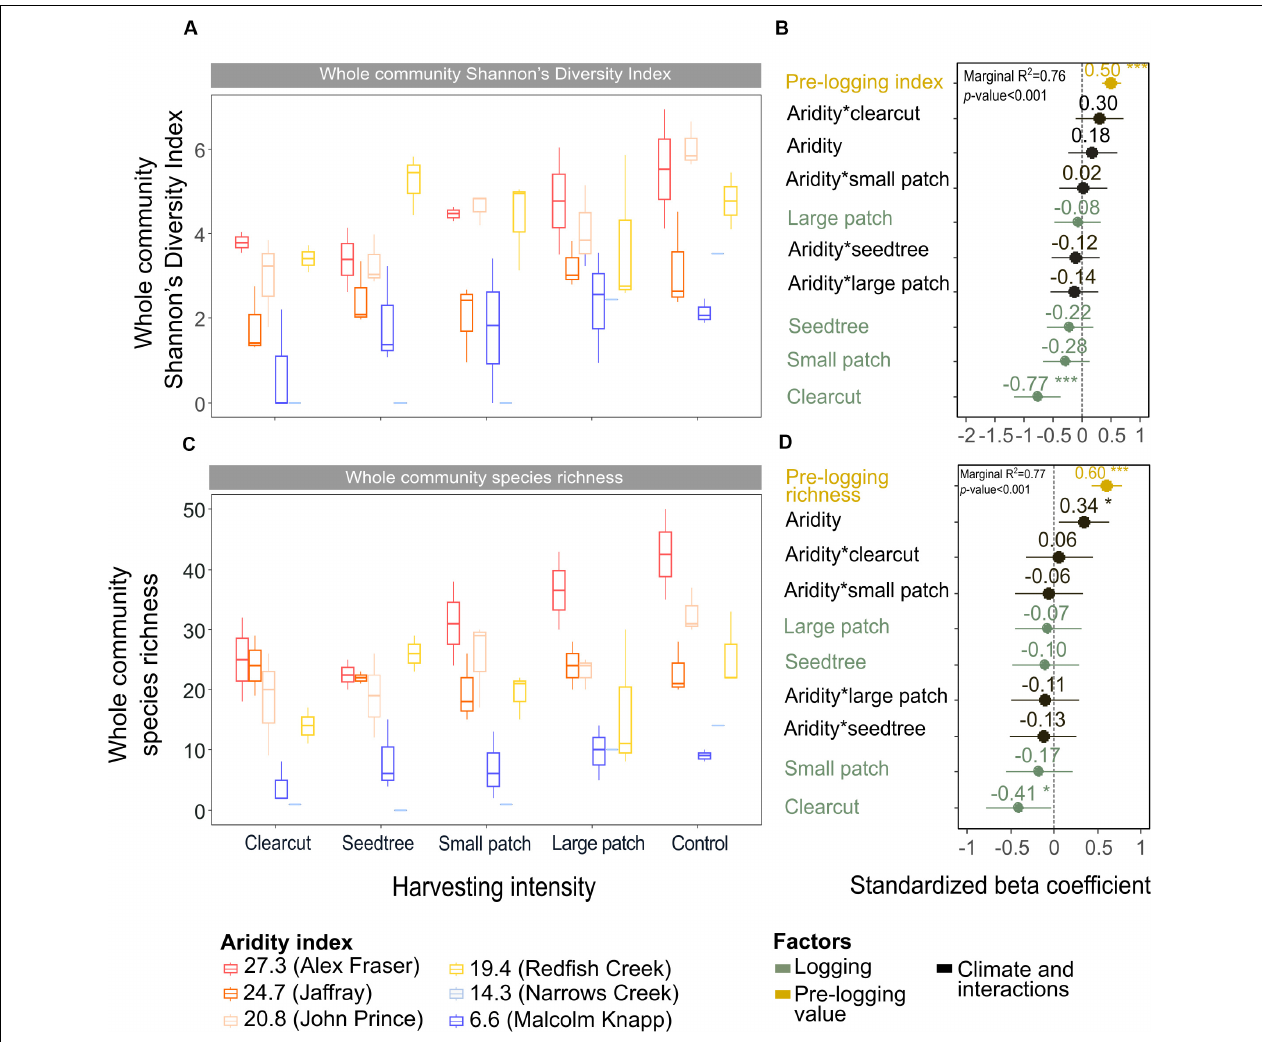
FIGURE 6 | Effect of harvesting intensity and climatic aridity on whole community Shannon’s diversity index (A,B) and plant species richness (C,D) of mixed Douglas-fir forests ( n = 3 for all locations, except Narrows Creek where n = 1, and Alex Fraser where n = 2). The counts for plant species richness include all vascular plants and bryoid species. (B,D) present standardized beta coefficients of linear mixed-effect models. Beta coefficients illustrate the effect of factors on Shannon’s diversity index (B) and on plant species richness (D) in terms of their standardized effect sizes. Circles indicate average estimates and lines indicate 95% confidence intervals. The aridity index was calculated as [mean annual temperature + 10]/[mean annual precipitation/1000]. For harvesting intensity, each coefficient represents the difference between the uncut control and a given treatment. *** P -value < 0.001; ** P -value < 0.01; * P -value <